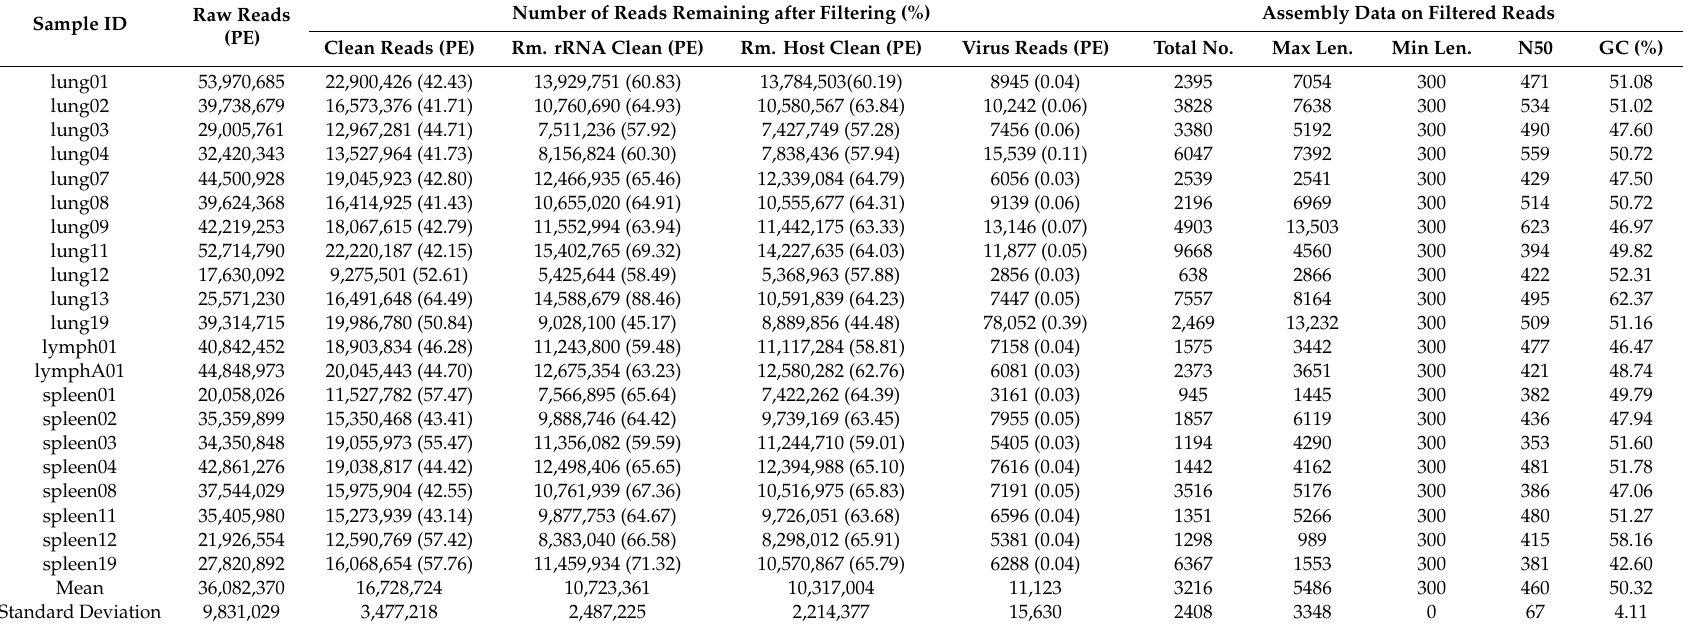
Table 1. Overview of reads and contig sequences of lung, lymph, and spleen tissues from 11 dead Malayan